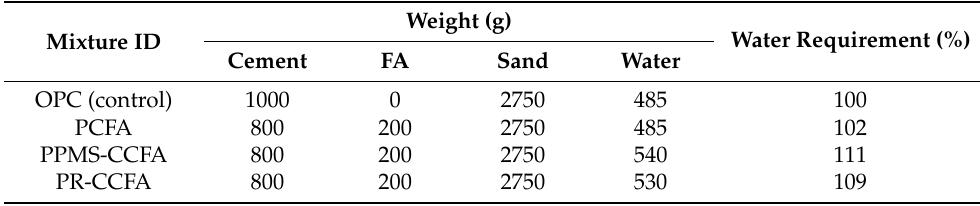
Table 4. Mixture proportions of cement